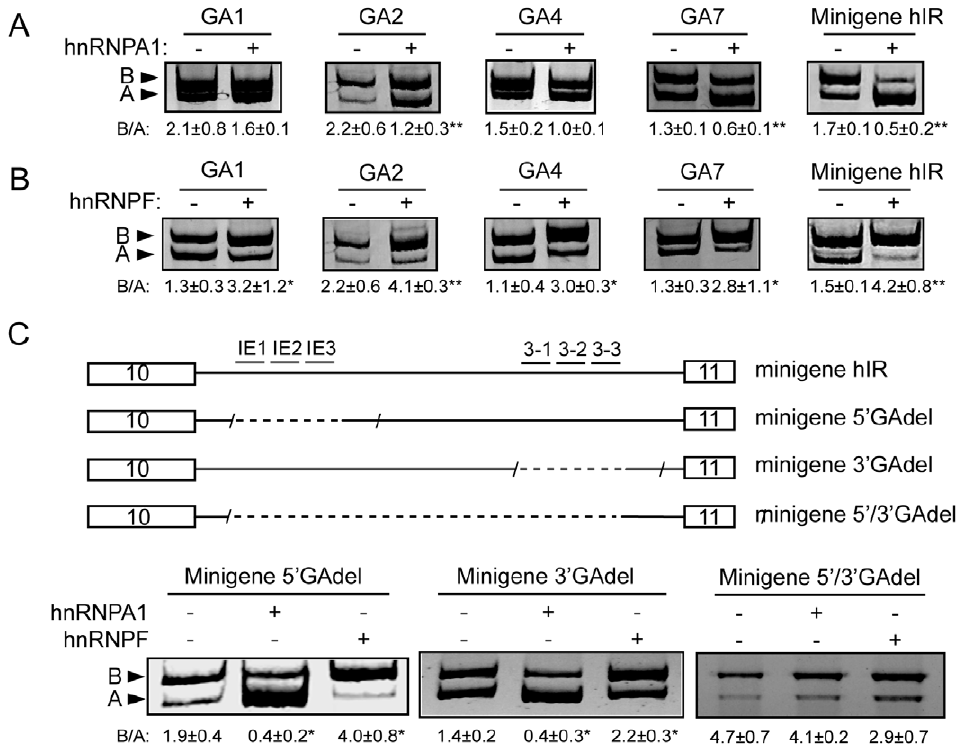
Figure 4. Linker scanning mutants do not disrupt the effect of hnRNP A1 or hnRNP F. Panels A and B: Co-transfection of linker scanning mutants GA1, 2, 4 and 7 and minigene hIR with the expression vector for hnRNP A1 (Panel A) and hnRNP F (Panel B). Panel C: Schematic of the deletion constructs spanning 5 9 (IE1, IE2 & IE3) or 3 9 (3-1, 3-2 & 3-3) binding sites (5 9 GAdel and 3 9 GAdel, respectively), or the combined 5 9 /3 9 GA deletion construct, which lacks all GA-rich binding sites and the central 1.9 kb of the intron. Deletion mutants were co-transfected with hnRNP A1 or hnRNP F in HepG2 cells. Total RNA was isolated 48h after co-transfection. The relative expression level of the IR isoforms was measured and analyzed as described previously. The ratio of isoform B over isoform A of n=3 experiments with 6 SD is shown. Asterisks indicate statistical significance vs. vector alone (* p # 0.05, **p # 0.01).